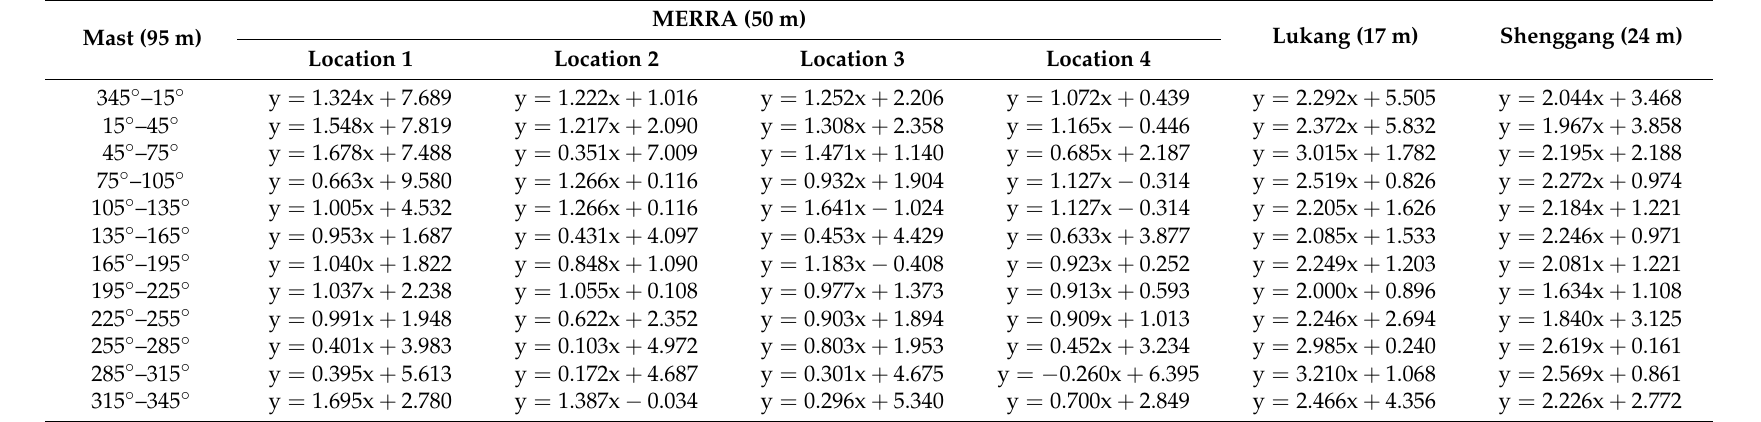
Table 7. Correlation formulas of wind speed between mast (95 m) and MERRA 1–4 and CWB Lukang and Shenggang for 12